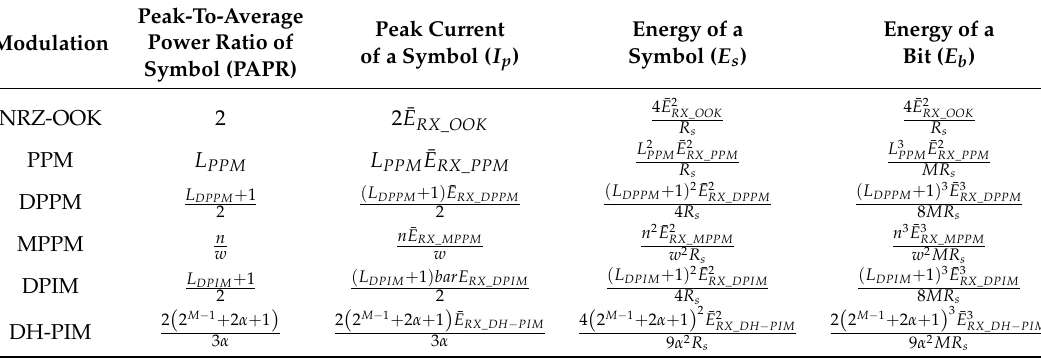
Table 2. Comparison of power characteristics of digital pulse modulation techniques.